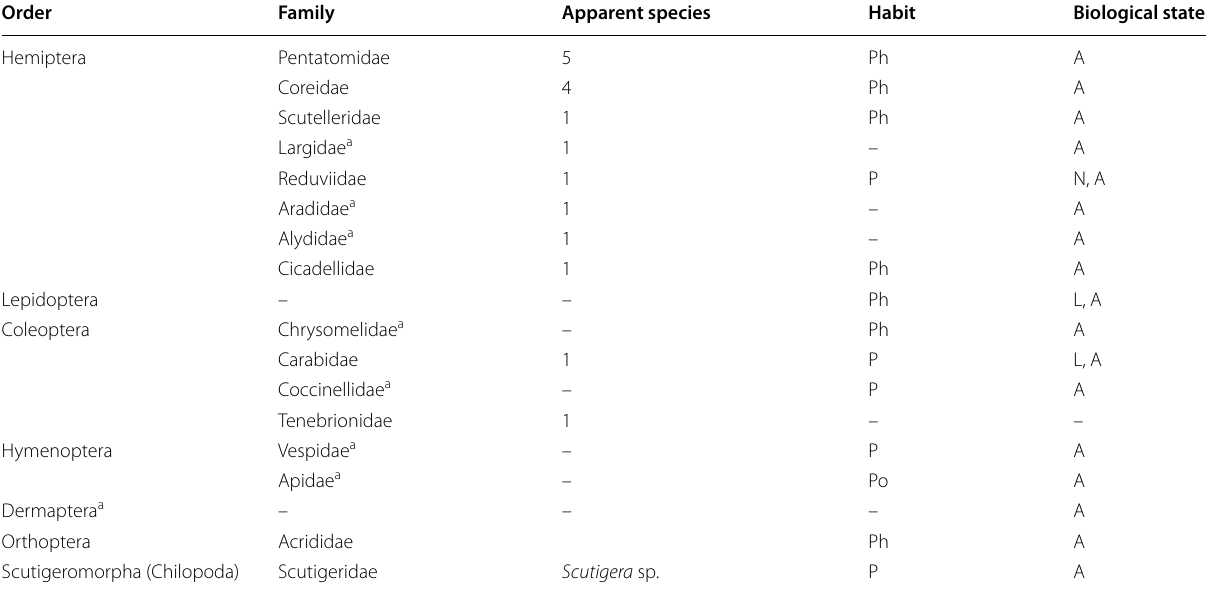
Table 1 Arthropods associated with the stink bug Oebalus mexicana in hibernation sites of the Zináparo hill, Michoacán,